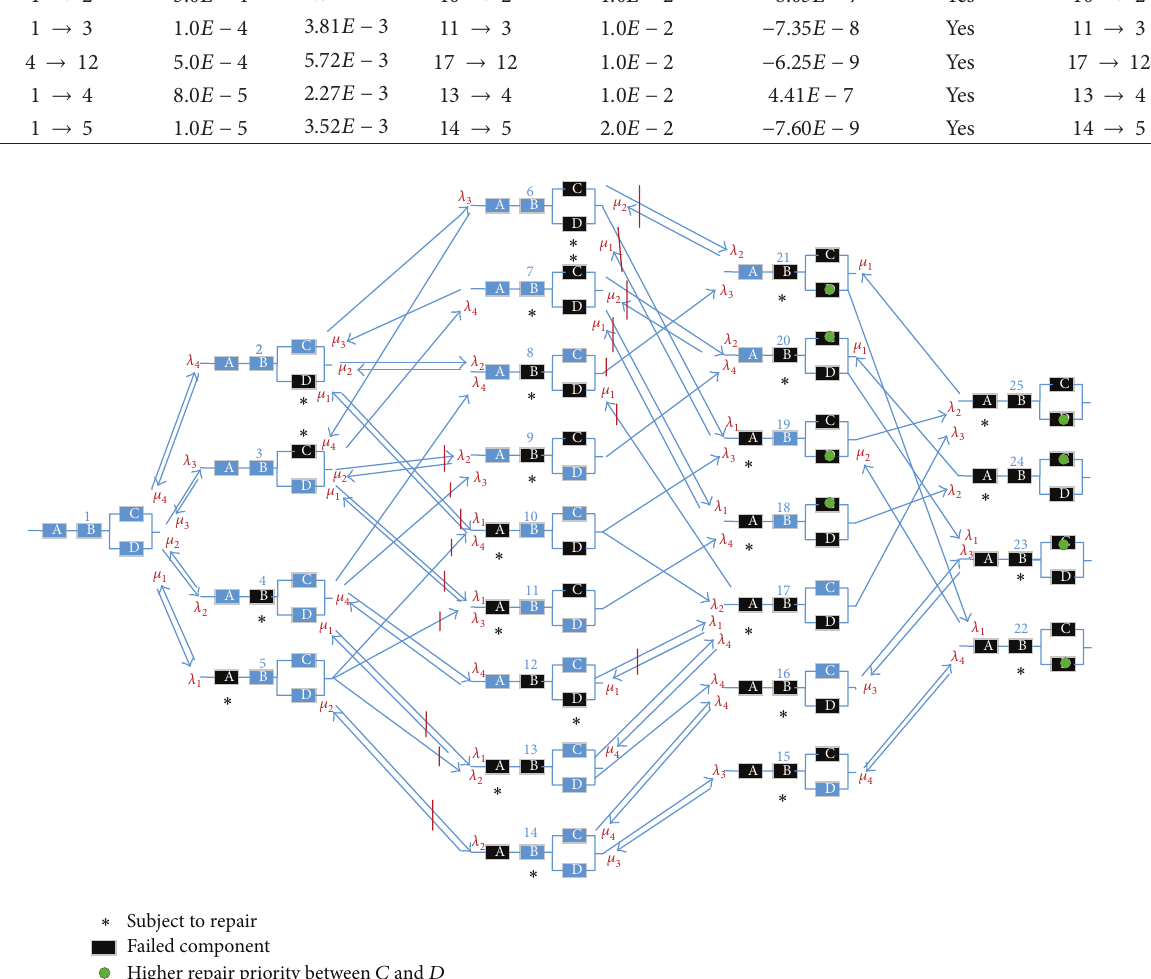
Figure 3: State transition diagram with cut performed (retained states to the left of the red